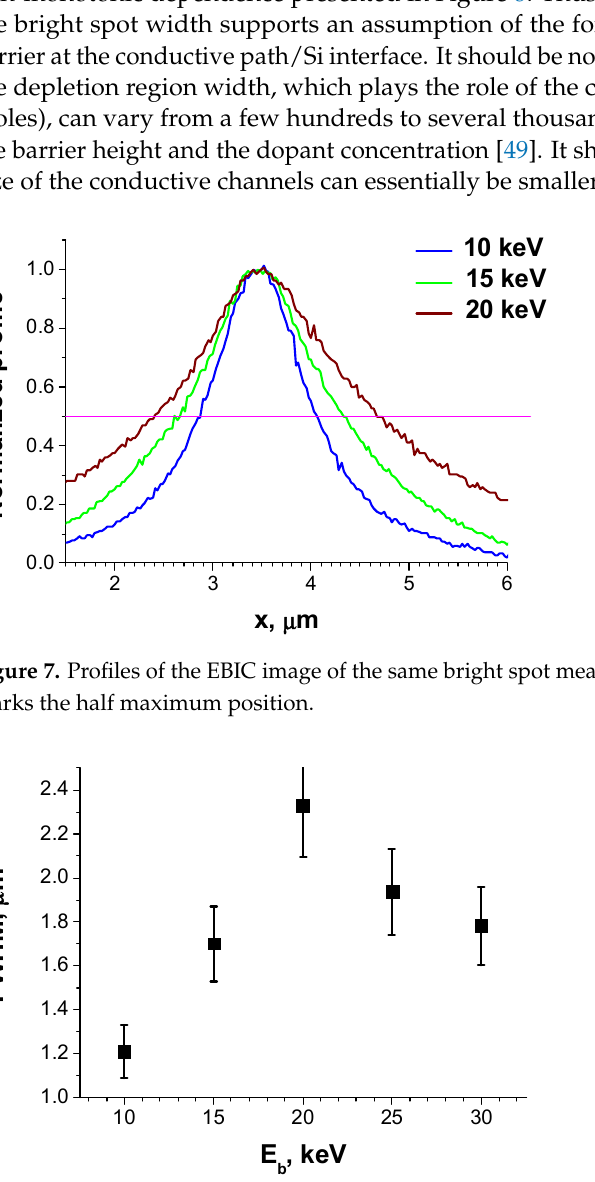
Figure 8. Dependence of FWHM of the conductive channel EBIC profile on E b .